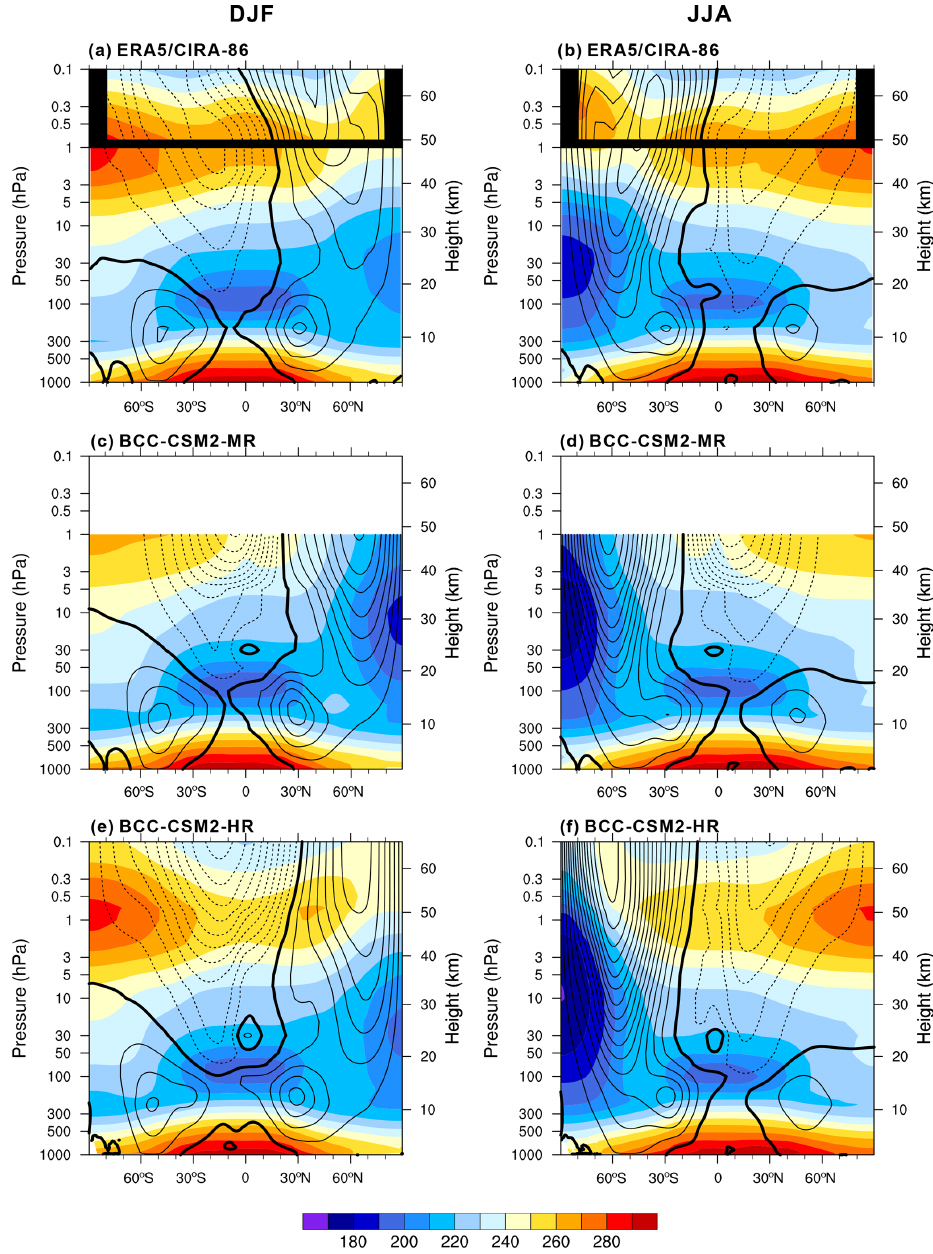
Figure 5. The zonal means of temperature (colours; K) and zonal wind (contours; ms − 1 ) averaged for December–January–February (a, c, e) and June–July–August (b, d, f) from 1995 to 2014 for (a, b) ERA5/CIRA86, (c, d) BCC-CSM2-MR, and (e, f) BCC-CSM2-HR. Positive (negative) zonal winds are plotted with solid (dashed) lines with a contour interval of 10ms − 1 . Thick contour lines denote zero zonal wind speed. In (a) and (b) , the values above 1hPa from the COSPAR International Reference Atmosphere (CIRA86, Fleming et al., 1990) and below 1hPa from the ERA5